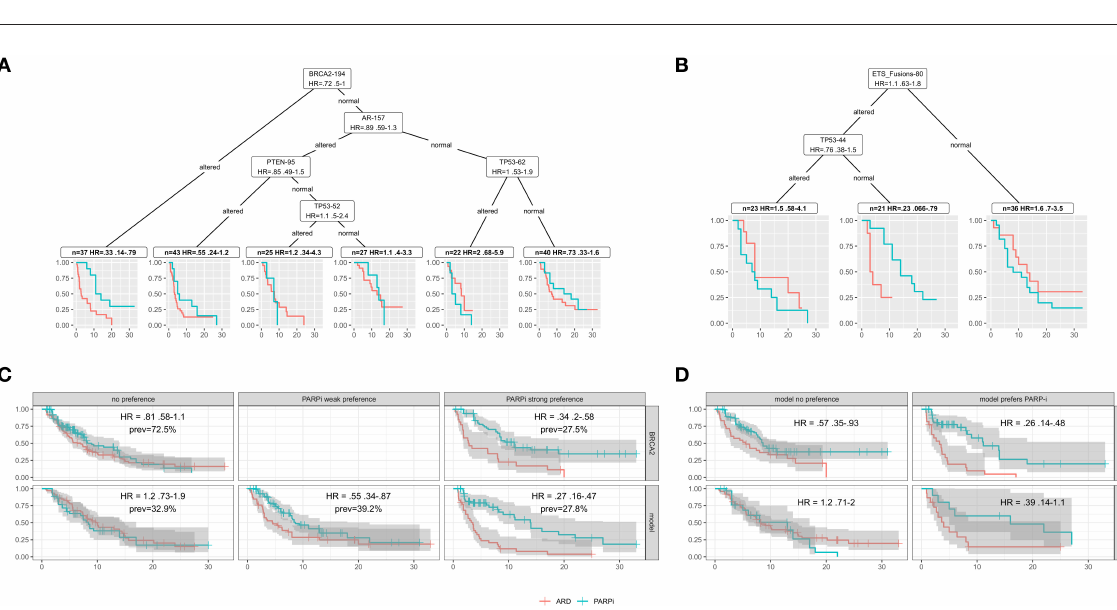
treatment hazard ratios. The model-based partitioning (MOB) tree (Zeileis et al., 2010) identifies BRCA2 as the strongest treatment differentiator. It prioritizes AR next, perhaps due to ARD resistance in the altered subgroup.